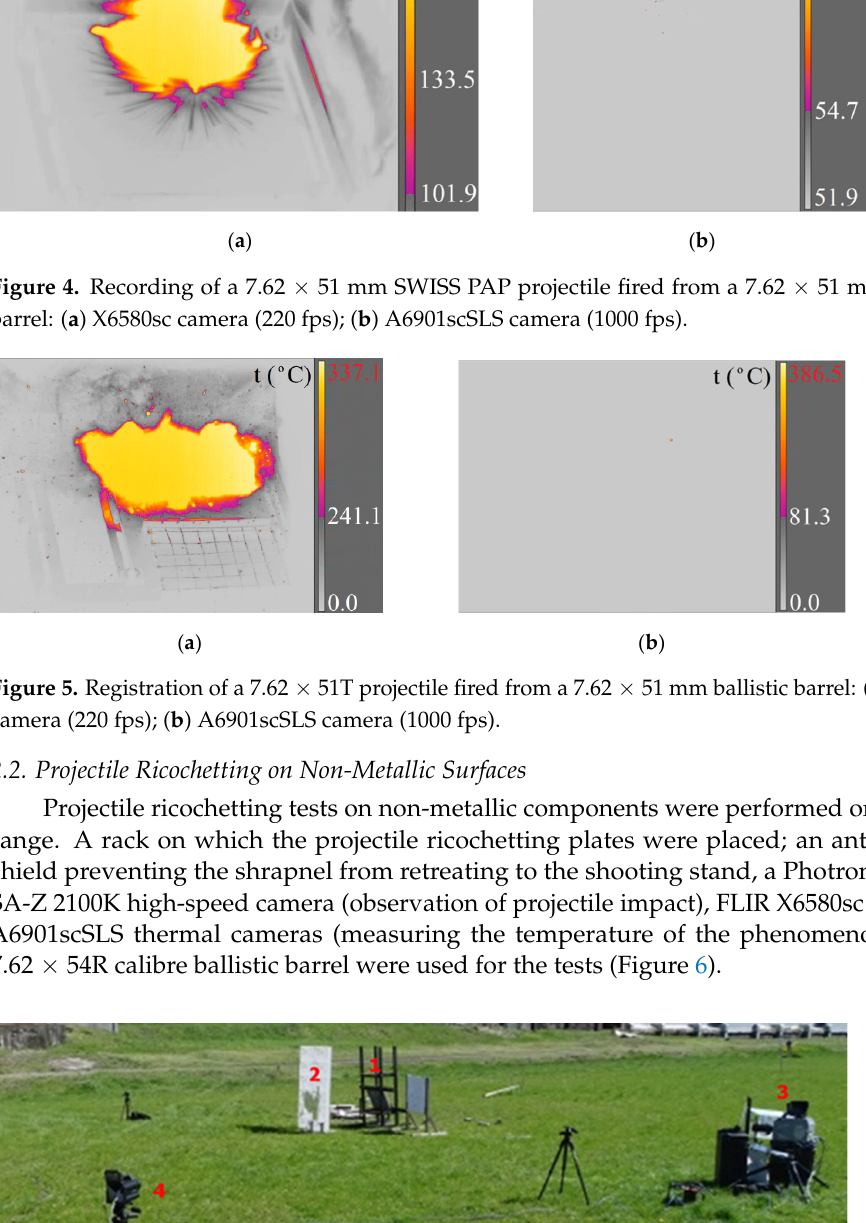
Figure 3. Recording of a fragmented projectile striking an Armox 600 armour plate (Photron Fast ‐ cam SA ‐ Z 2100K ‐ 50,400 fps): ( a ) 7.62 × 51 mm SWISS PAP projectile; ( b ) 7.62 × 51T projectile flash caused by the rapid combustion of the streaker pyrotechnic mass.